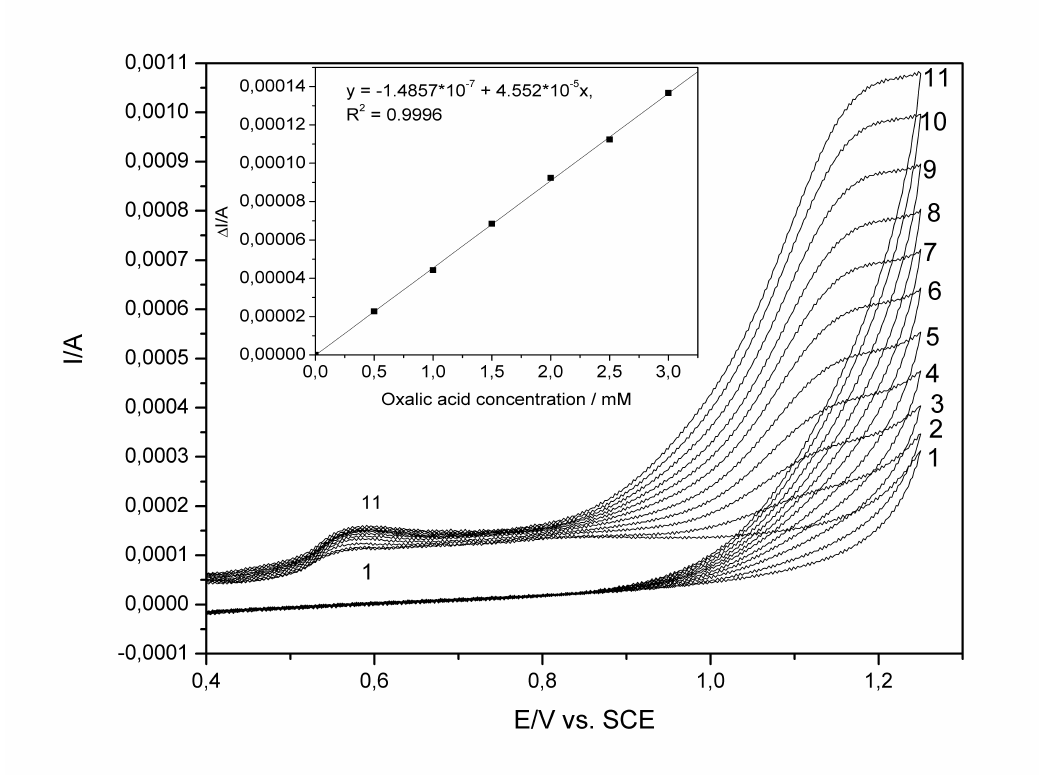
Figure 4. Cyclic voltammograms (3 rd scan)of EG-PS in the presence of oxalic acid concentrations:1-0 mM; 2-0.1 mM; 3-0.2 mM; 4-0.3 mM; 5-0.4 mM; 6-0.5 mM; 7-0.6 mM; 8-0.7 mM; 9-0.8 mM; 10-0.9 mM; 11-1 mM; potential scan rate0.05 Vs -1 ; supporting electrolyte 0.1 M Na of anodic limiting currents vs. oxalic acid